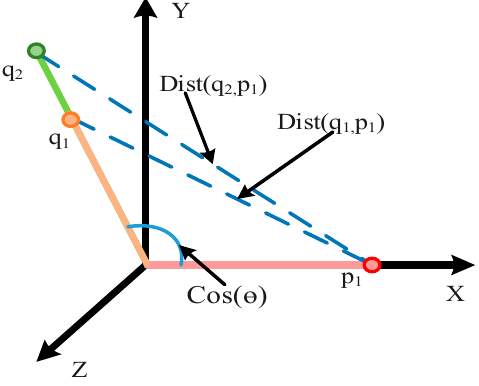
Figure 3. Schematic of Cosine Loss.